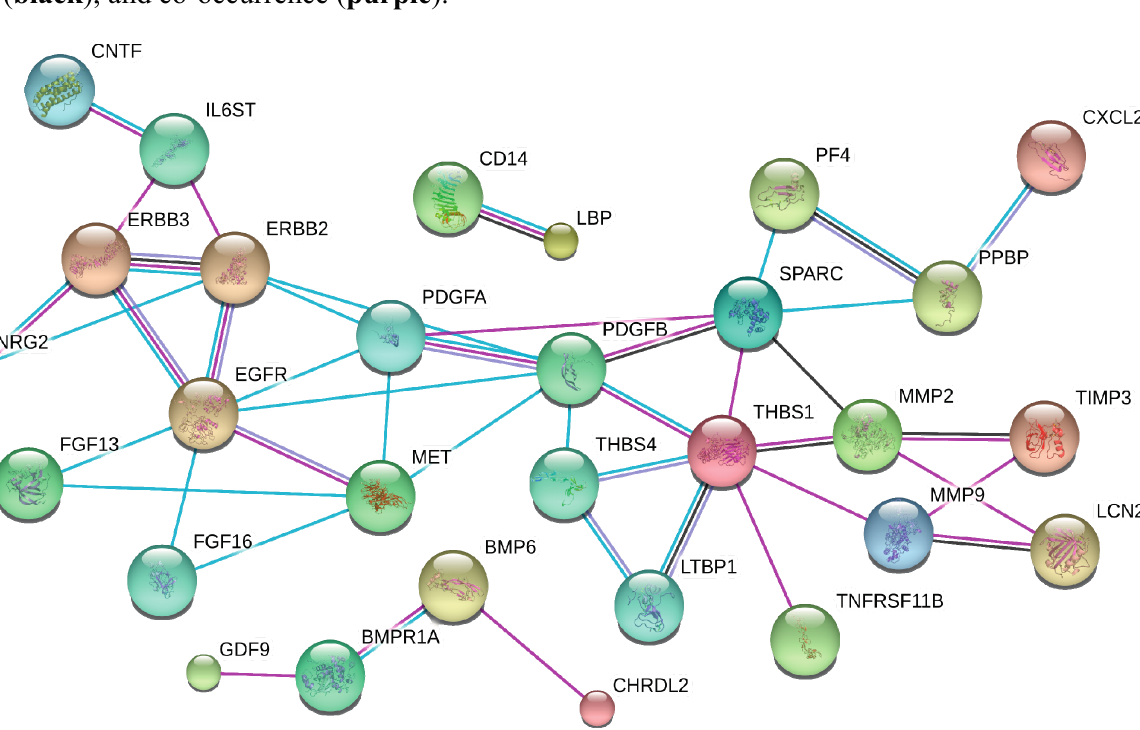
Figure 5. Locally Advanced Rectal Cancer—Radiation Response Prediction: the network of interacting proteins, shown by their gene names and whose serum levels were altered following the course of neoadjuvant treatment of the study patients, as determined by Search Tool for the Retrieval of Interacting Genes/Proteins. Connective lines represent the following types of evidence: experiments ( pink ), databases ( turquoise ), co-expression ( black ), and co-occurrence ( purple